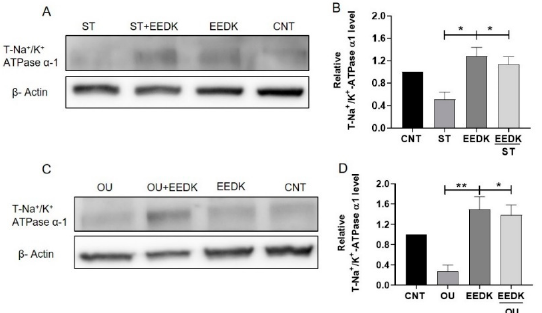
Figure 4. Protein expression of total-Na + /K + -ATPase α 1 subunit by western blot analysis. ( A ) Repre- sentative signals of expression. Top: Na + /K + -ATPase α 1 -subunit. Bottom: β -Actin, the relative inten- sity of each band to β -actin was measured by a densitometer as the expression of Na + /K + -ATPase α 1 -subunit. ( B ) Representative graph of 4A. Cells were exposed to ST 5 nM and ST with EEDK 2 µ g/mL. Only EEDK and non-treated cells were used as controls after 24 h of treatment cells were assayed to analyze the expression level of Na + /K + -ATPase α 1 . ( C ) Representative signals of expression. Top: Na + /K + -ATPase α 1 -subunit. Bottom: β -Actin. ( D ) Representative graph of 4C. Cells were incubated with OU 50 nM with and without EEDK 2 µ g/mL. Non-treated cells and only EEDK treated cells represent controls. Data are presented as the mean ± SEM of values from three experiments, * p < 0.05, ** p < 0.01 for the indicated comparisons (one-way ANOVA with Tukey’s multiple comparison